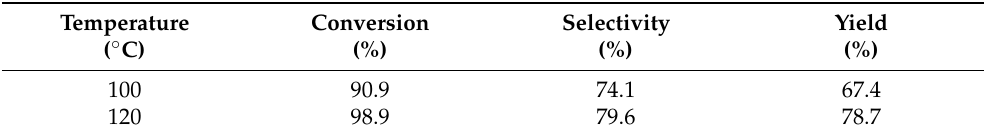
Figure 12. The histograms of the PC yield for CO 2 /PO cycloaddition reactions using the APTMS-modified Zr–Mg mixed oxide aerogels with Zr/Mg molar ratio of 7/3 under different reaction temperatures. Table 4. The PO conversion, PC selectivity, and PC yield using the APTMS-modified Zr–Mg mixed oxide aerogels with Zr/Mg molar ratio of 7/3 under four APTMS modifications at different reac- tion